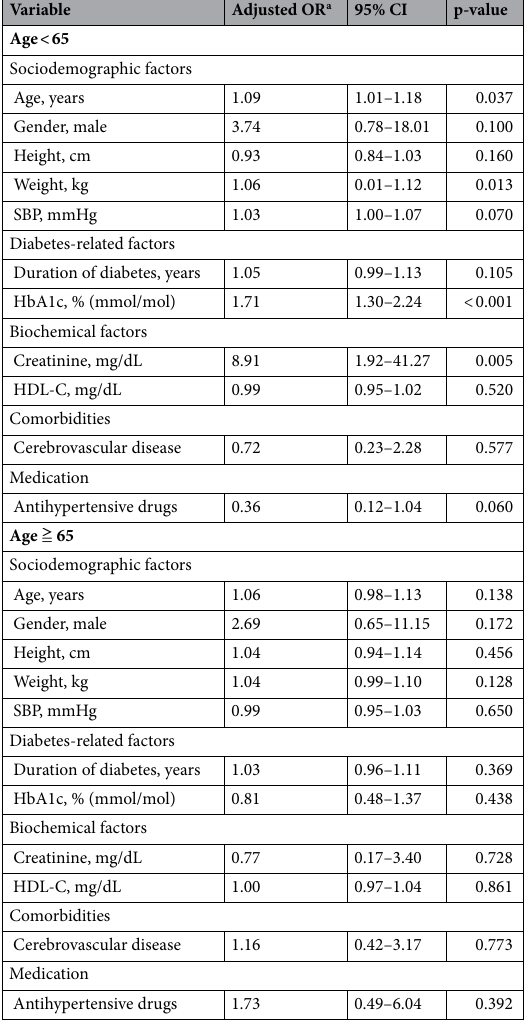
Table 4. The association between serum creatinine concentration and future DPN, stratified by age group into age < 65 and ≧ 65. OR odds ratio, CI confidence interval, SBP systolic blood pressure, HbA1c glycated hemoglobin, HDL-C high-density lipoprotein cholesterol. a Each group was adjusted for age, gender, height, weight, SBP, duration of diabetes, HbA1c, creatinine, HDL-C, cerebrovascular disease and antihypertensive